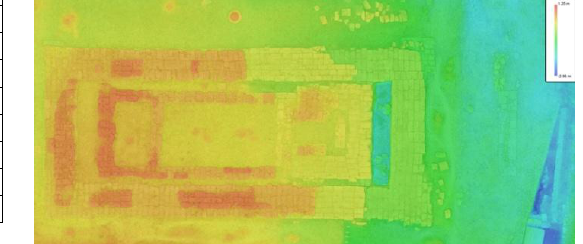
Figure 8: DEM of the